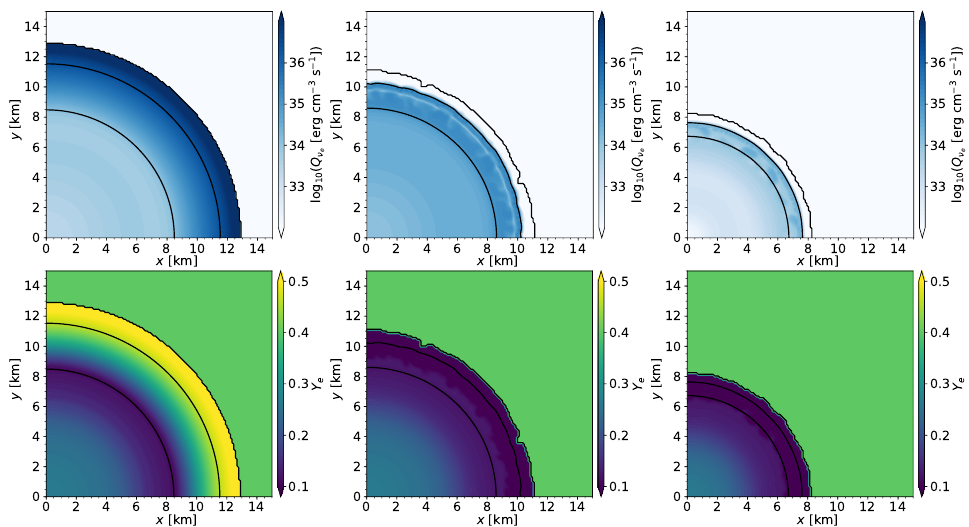
Figure 4. Snapshots of the A- ν simulation at t = 0.00, 1.08, 2.66 ms from left to right. Upper panels: logarithm of the electron neutrinos emissivity. Lower panels: electron fraction. The solid black lines ( ρ [ g cm − 3 ]) = 7,12,14. The outermost line are contours of constant rest-mass density with log 10 marks the interface between the star and the